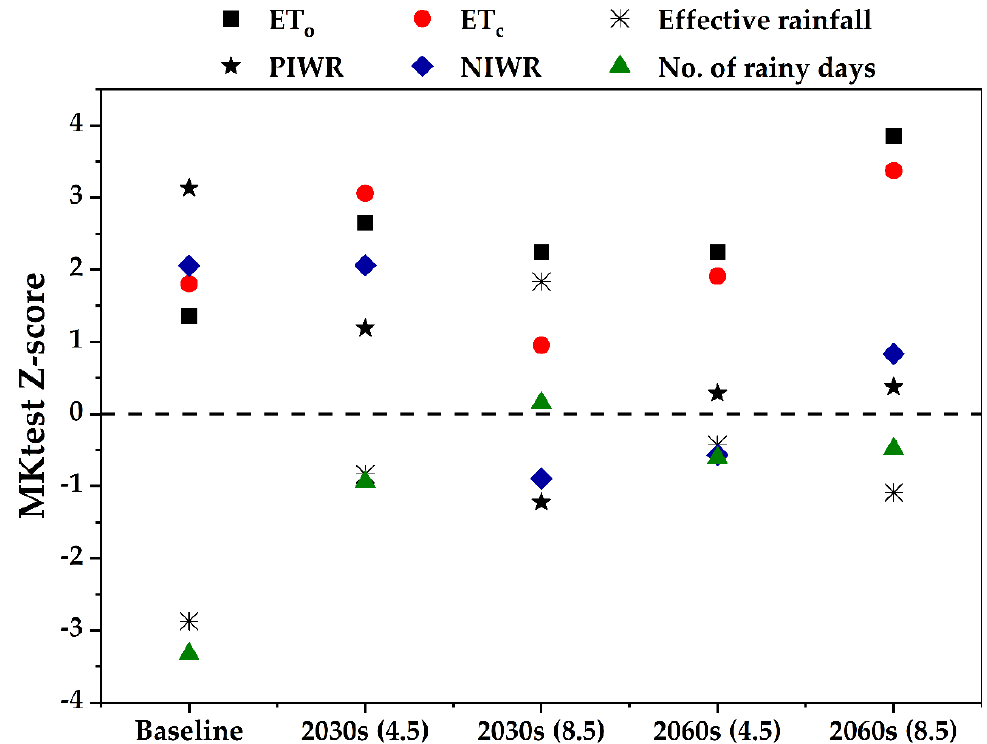
Figure 6. MK test Z-scores for wheat seasonal (November–April) cumulative reference evapotran- spiration (ET o ), crop evapotranspiration (ET c ), effective rainfall (ER), potential irrigation water requirement (PIWR), net irrigation water requirement (NIWR), and number of rainy days (N) during the baseline (1980 − 2010), 2030s (2021 − 2050), and 2060s (2051 − 2080). Table 2. Sen’s slope of trends for the wheat irrigation management components during the baseline and future time slices.